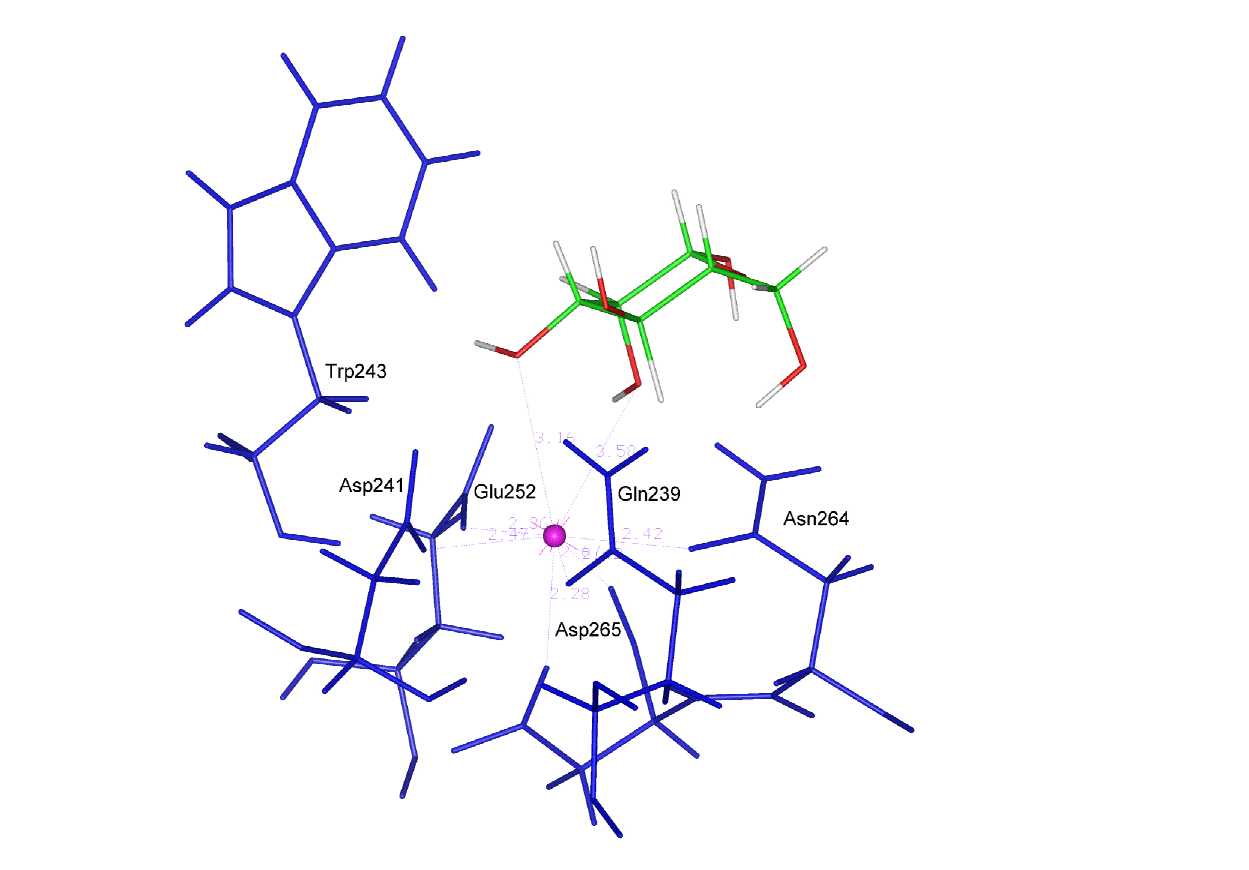
Figure 2. One of the three structure of Mannose optimized in the binding